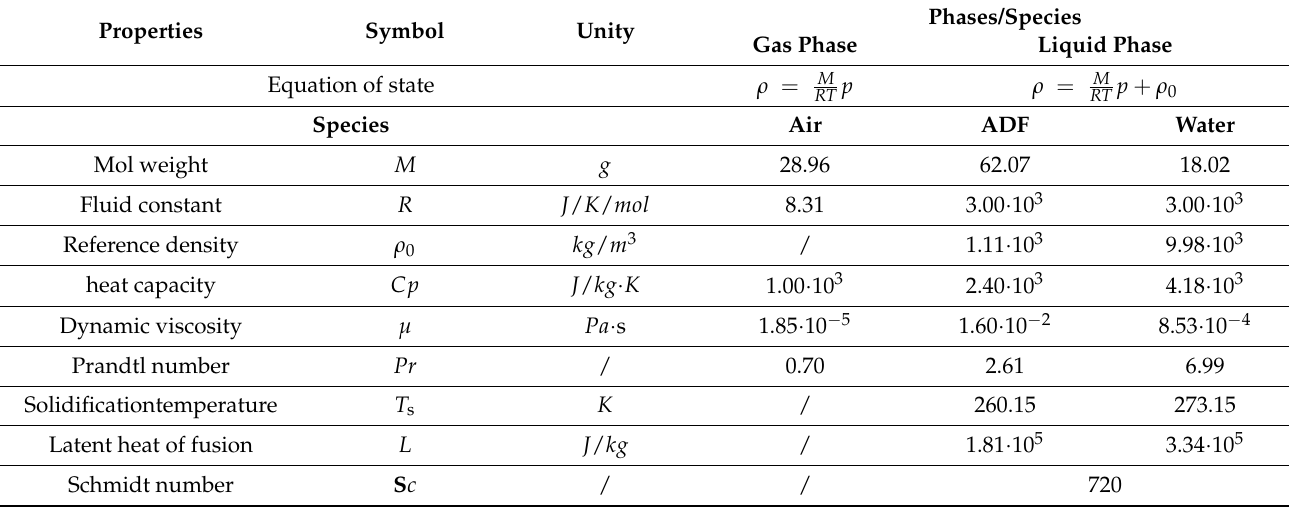
Figure 13. Initial conditions for the permeability coefficient calibration. Table 7. Thermophysical